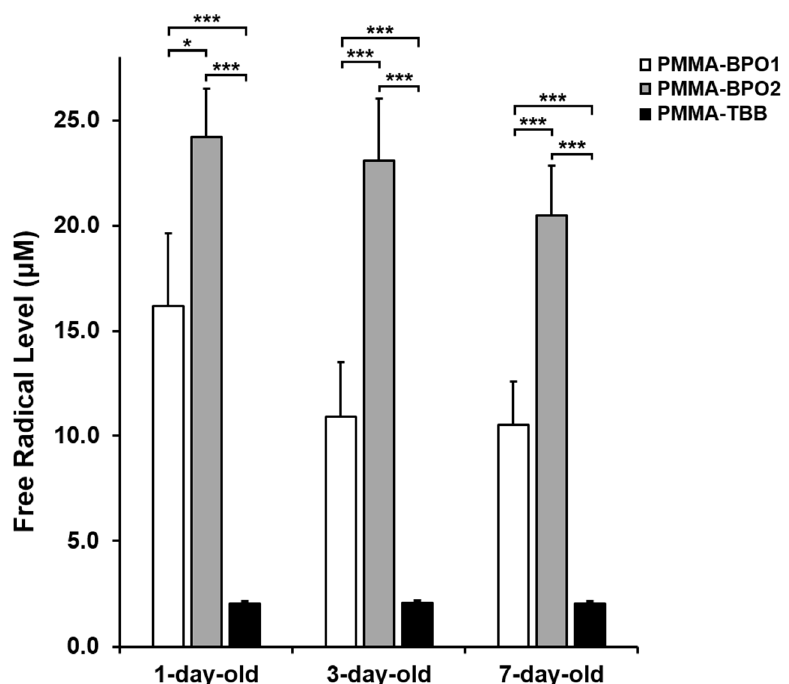
Figure 8. Free radical generation from the three different bone cements prepared for different times evaluated by electron spin resonance spectroscopy (ESR). Data are shown as mean ± SD ( n = 3). Significant difference shown only compared with PMMA-TBB (two-way ANOVA followed by Bonferroni test, * p < 0.05, *** p < 0.001).